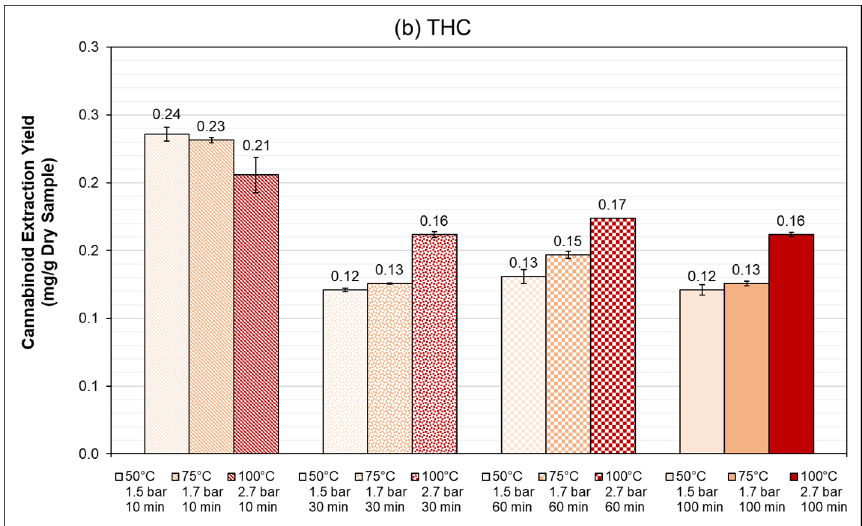
Figure 3. Cannabinoid extraction yield of the PLE experiments performed in the 1 L autoclave with hemp variety KC Virtus (Section 2.5, Table 1). ( a ) CBD, and ( b ) THC. Average value of the duplicates. ANOVA analysis: p -values were 0.01 and 0.89 for CBD and THC, respectively.